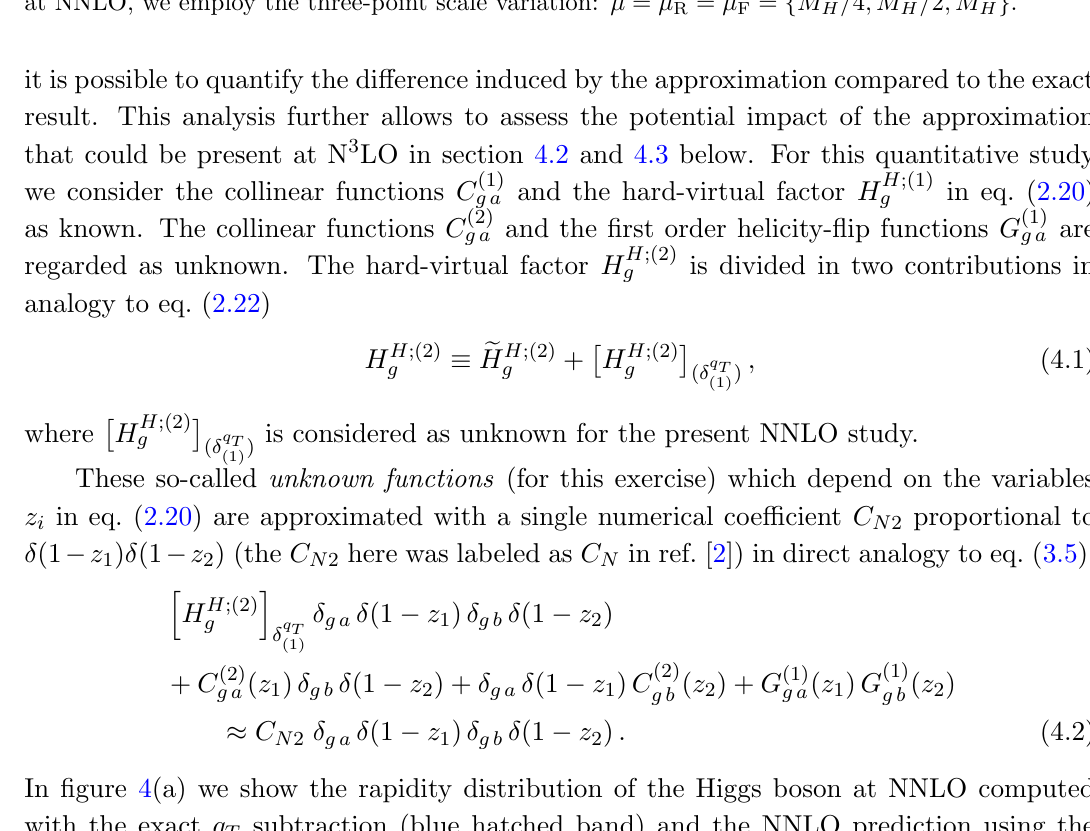
Figure 4 . Comparison of the rapidity distribution between the exact result at NNLO (blue hatched) and an evaluation using the C N 2 numerical coe(cid:14)cient (cross, dot and square points). We perform the comparison both at the level of (a) the full NNLO cross section and (b) for the coe(cid:14)cient function H H ;(2) . The lower panels show the ratio to the exact result. For this particular example at NNLO, we employ the three-point scale variation: (cid:22) = (cid:22) R = (cid:22) F = f M H = 4 ; M H = 2 ; M H g